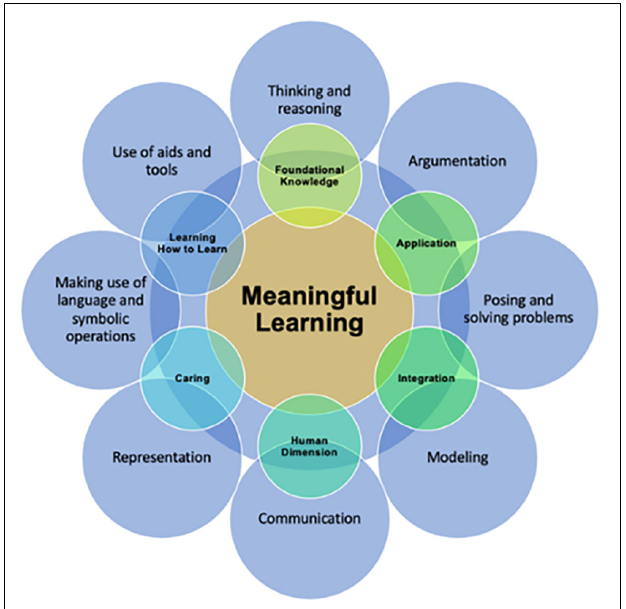
FIGURE 1 | Mathematical competencies and meaningful